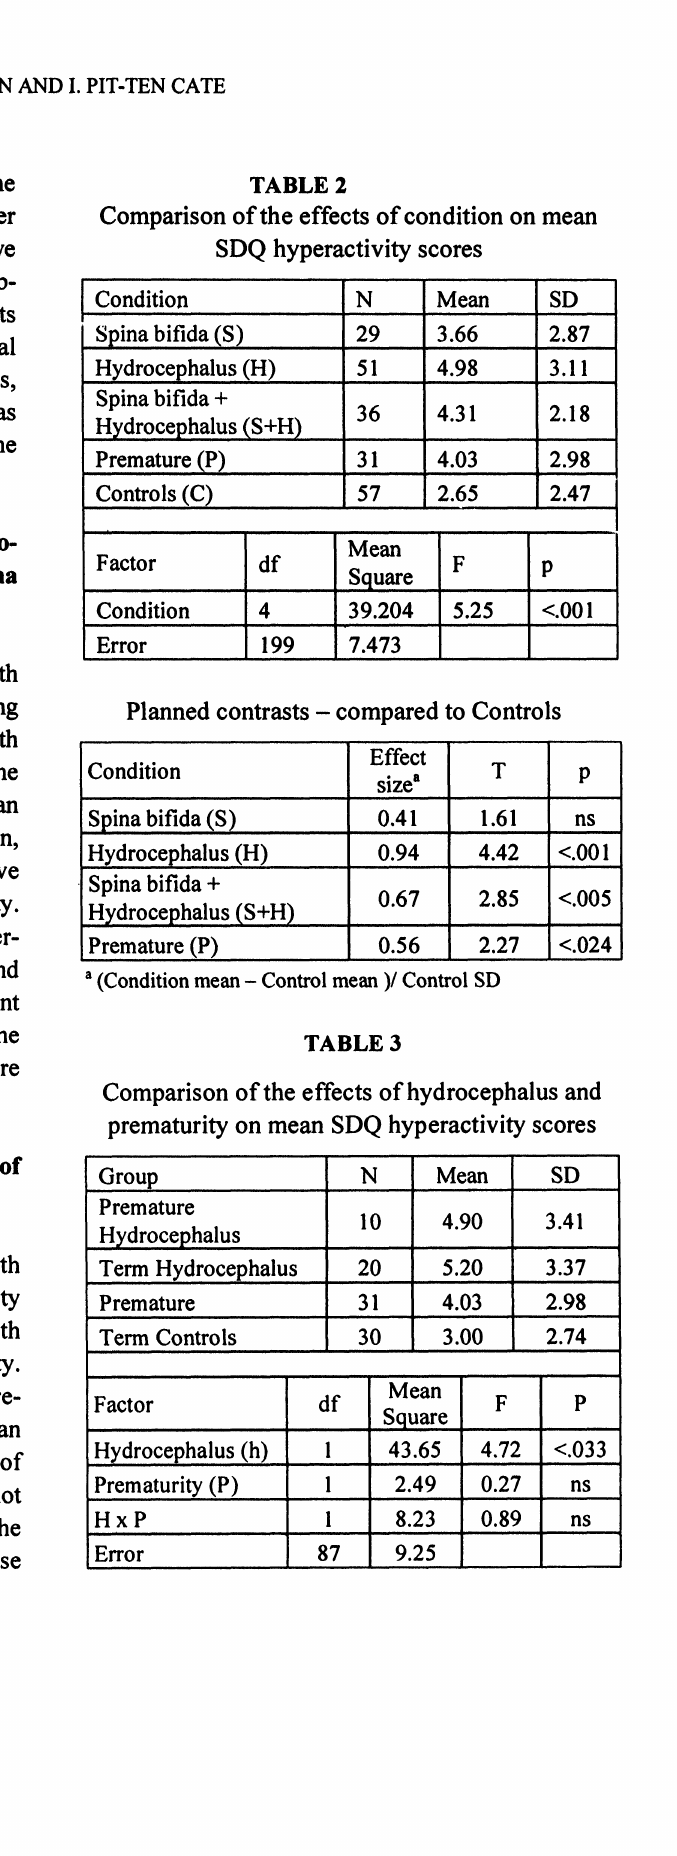
Comparison ofthe effects of condition on mean